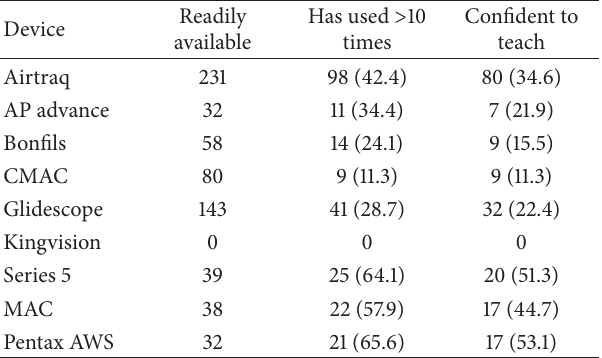
Table 3: DAS respondents who had ready access to a device, had used it more than ten times, and were confident to teach its use (2012